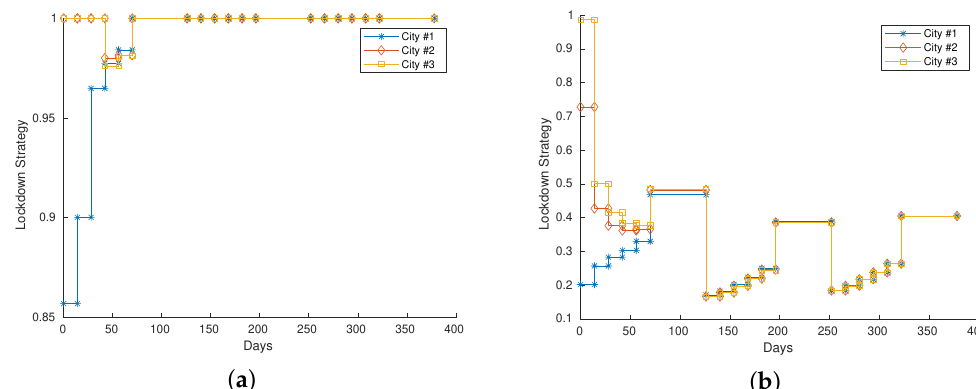
Figure 1. ( a , b ): Lockdown strategies for Scenario A and B, respectively. We show the optimal strategy V that minimizes (7) the closer is to 0, the more severe the restrictions are. On the other hand, values close to 1 denote very mild restrictions on